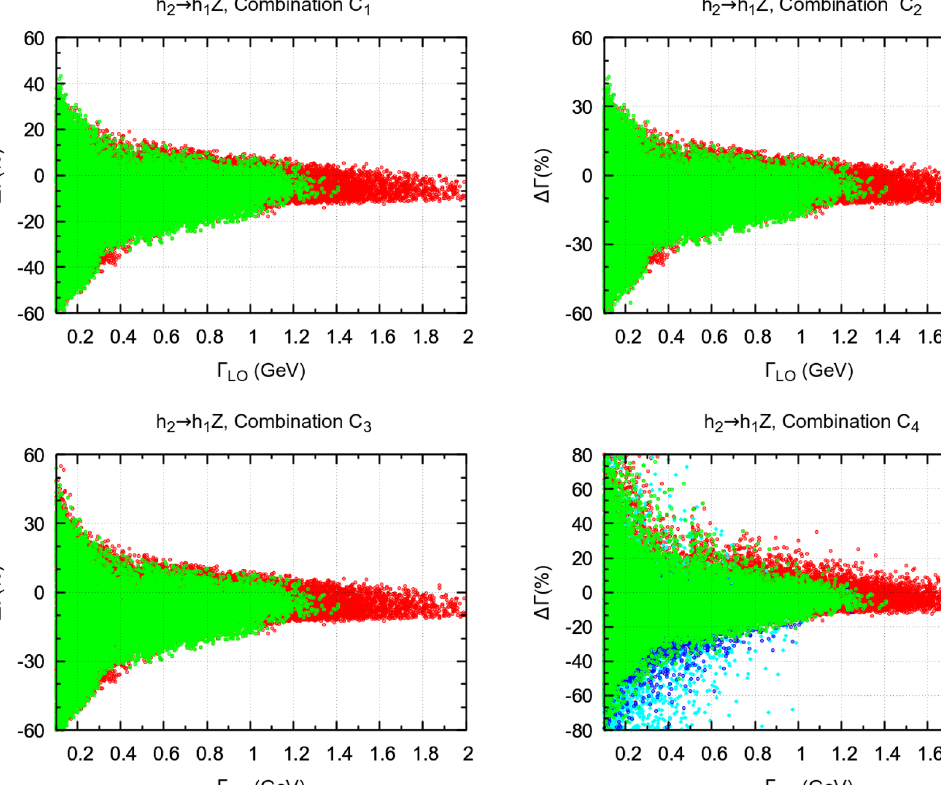
Figure 4 . ∆Γ h in percentage as a function of Γ LO , for the combinations C 1 (top left), h 2 → h 1 Z 2 → h 1 Z C 2 (top right), C 3 (down left) and C 4 (down right). Only the interval 0 . 1 GeV < Γ LO < 2 GeV is shown. The color conventions for C 1 , C 2 and C 3 are those of figure 1, whereas for C 4 are those